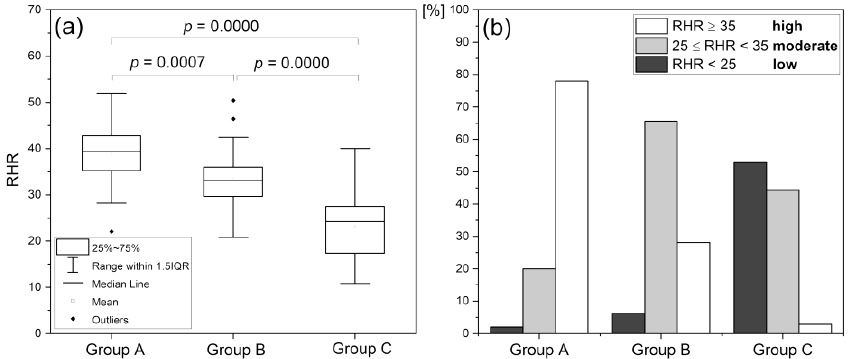
Figure 6. Assessment of RHR parameter in groups A, B, and C: A – highly trained endurance athletes; B – healthy middle-aged individuals; C – diabetes type 2 patients; ( a ) statistical differentiation (one- way ANOVA with the Scheffe post hoc test) of groups A, B, and C based on the RHR parameter; ( b ) distribution of the RHR parameter [43]. Reproduced from: Katarzynska, J.; Zielinski, J.; Marcinek, A.; Gebicki, J. New Approach to Non-Invasive Assessment of Vascular Circulation Based on the Response to Transient Ischemia. Vasc. Health Risk Manag. 2022 , 18 , 113–116; DOI:10.2147/VHRM.S358983, Dove Medical Press Ltd. publisher.